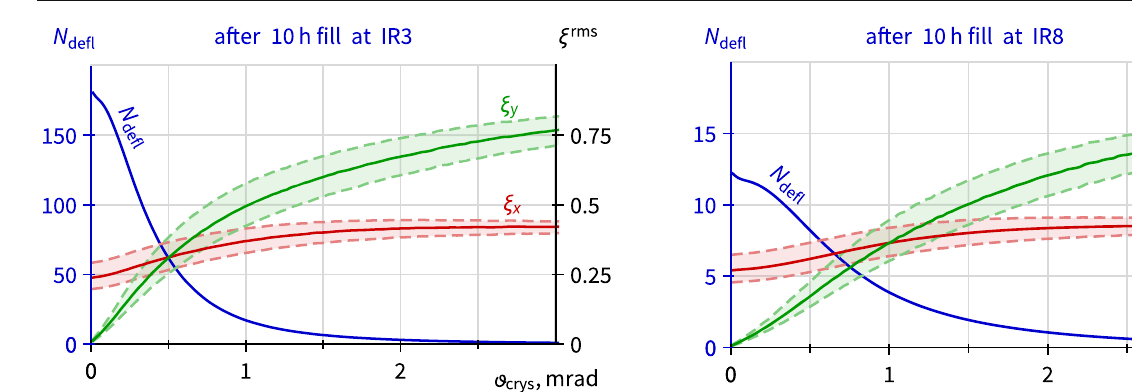
Fig. 4 Root mean square of initial polarisation projection of Λ c deflected by the crystal ( ξ x and ξ y – projections on axes Ox and Oy , respectively) and N defl – the integral number of deflected Λ c baryons